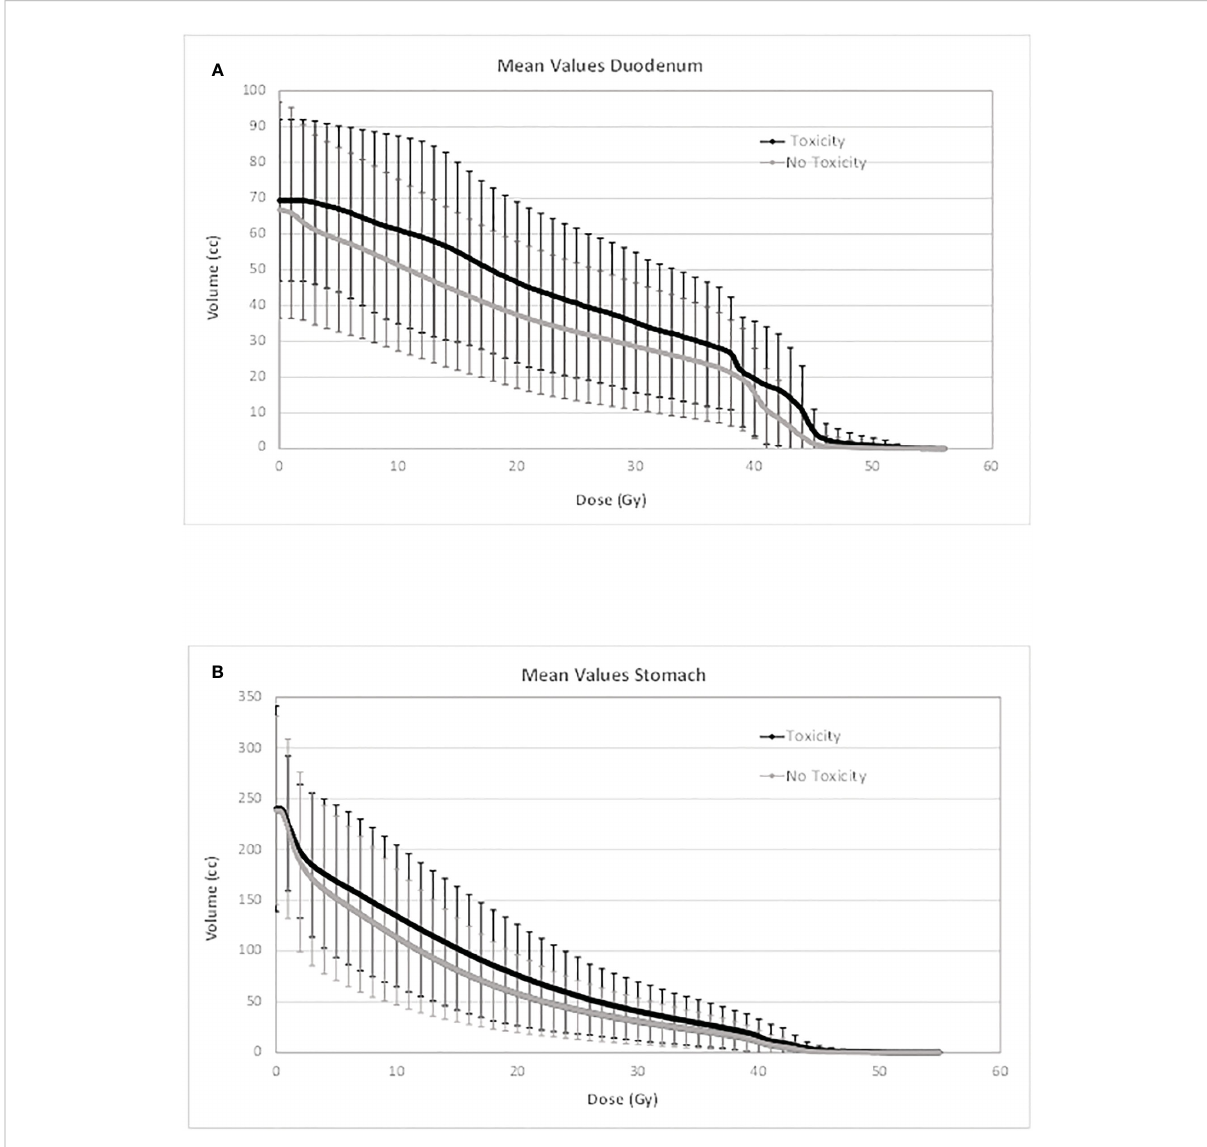
FIGURE 1 Average absolute DVH for duodenum (A) and stomach (B) for patients with and without toxicities. DVH, dose – volume